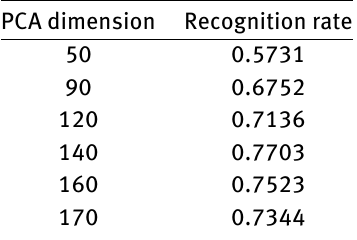
Table 2: Relationship between PCA Dimension and Recognition Rate